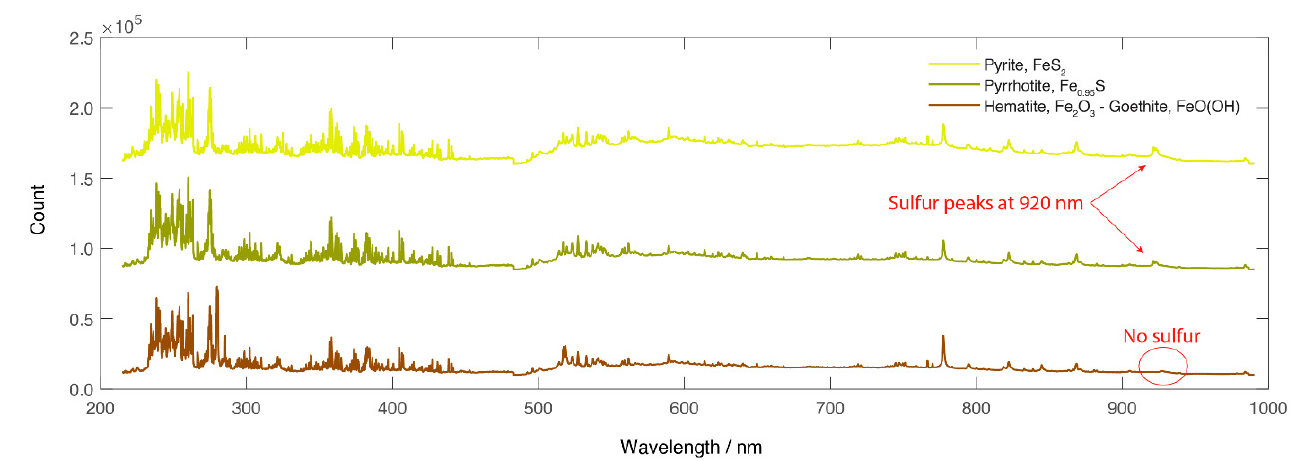
Figure 5. Full spectra of pyrite (yellow), pyrrhotite (green), and hematite–goethite (brown) assigned mineralogies.